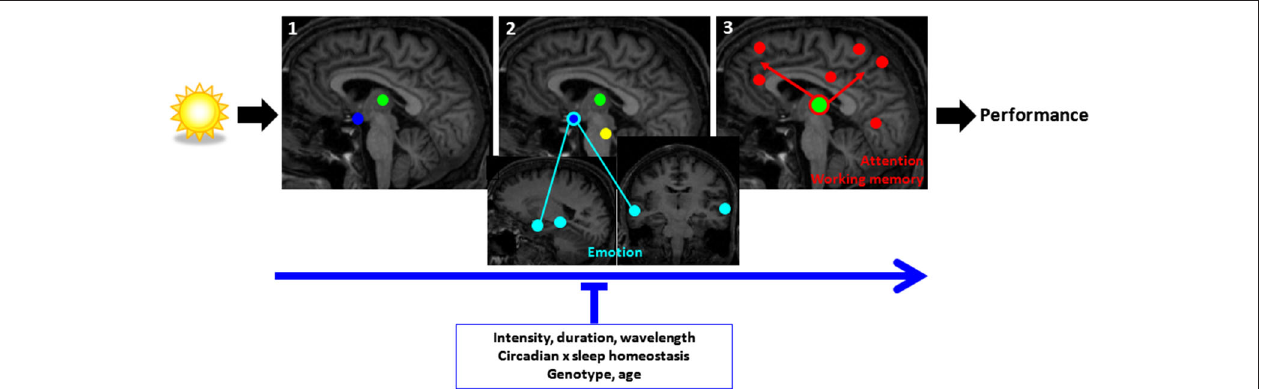
and including prefrontal and parietal areas appear to mediate the impact of light on alertness and cognition. For emotional responses to vocal stimuli (light blue), the network involves the hypothalamus, amygdala, and voice-sensitive area of the temporal cortex. Light seems to have a swifter impact on emotional cortical responses than attentional/working memory/executive responses. The impact of light is stronger with higher intensity, longer duration, and shorter wavelength (blue) light exposures. Time of day and the associated changes in the interaction between circadian and sleep homeostasis signals and PERIOD3 genotype modulate the impact of light. [Adapted with permission from Vandewalle et al.